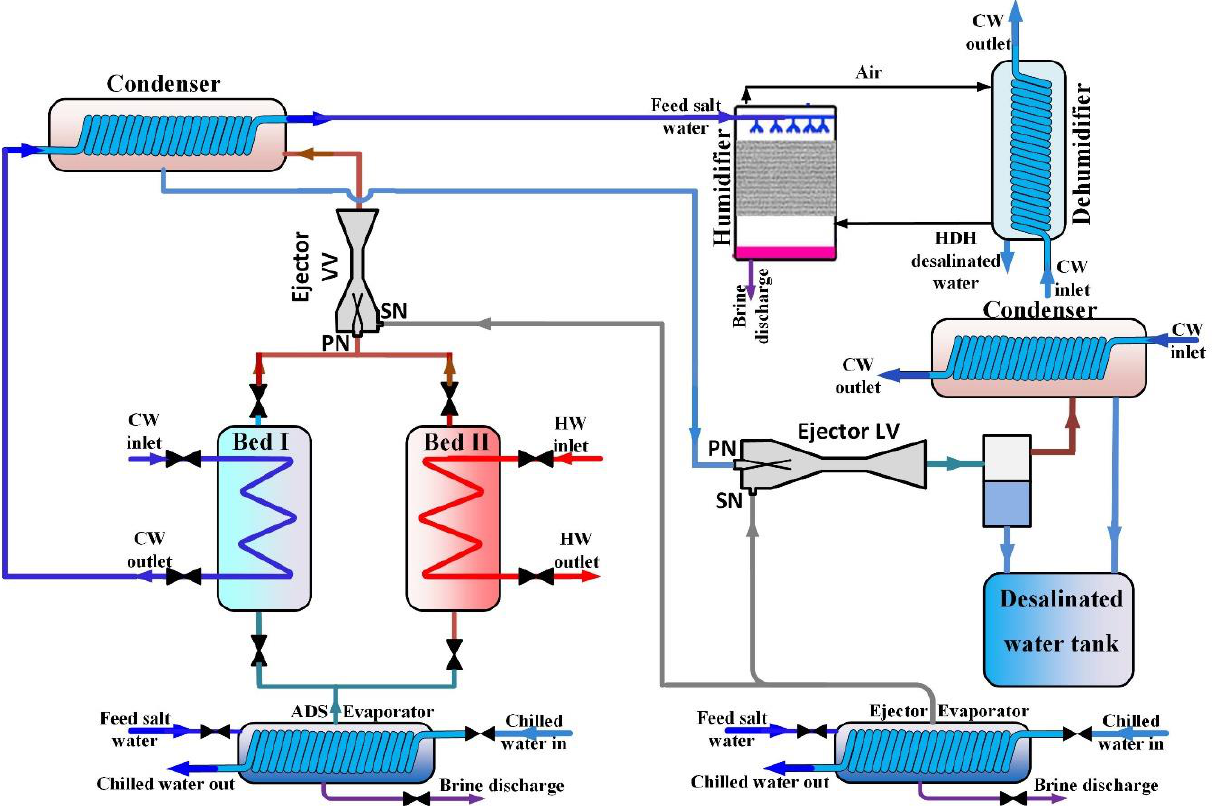
Figure 9. The hybrid HDH-AD2EJ system (adapted from [104]).